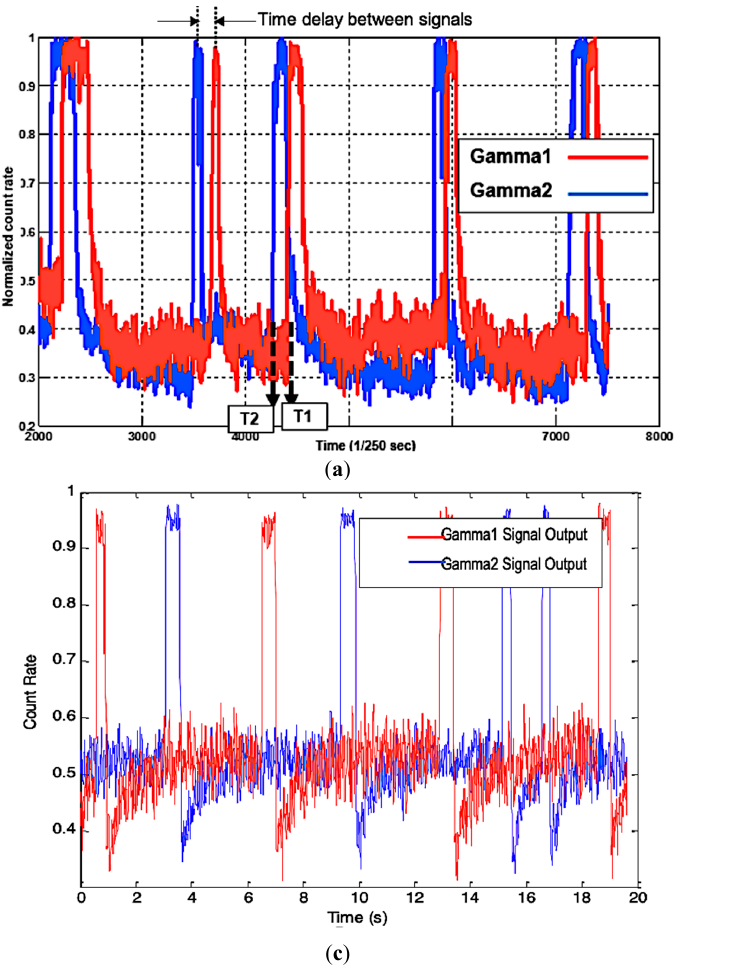
Figure 4. ( a ) Depiction of the determination of time delay for slug translational velocity from gamma densitometer time series ( a ) Typical liquid holdup plot showing the concept of signal time delay ( b ) an example of a raw signal output from gamma photon counts ( c ) an example of a filtered gamma signal output ( d ) Cross-correlation coefficient and time delay plot.